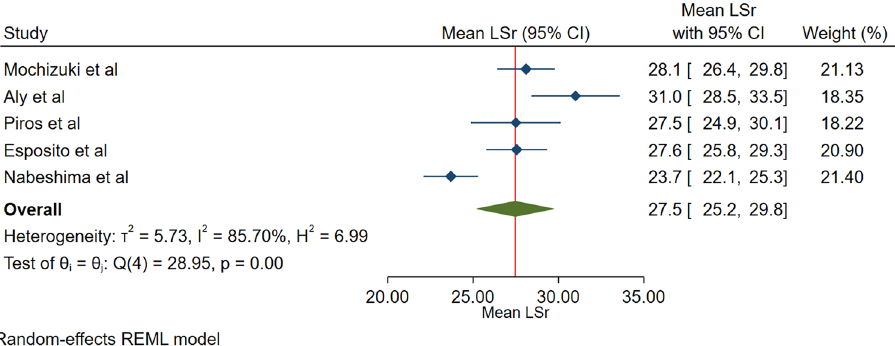
Figure 2. The image depicts the normal range of the longitudinal 3D speckle-tracking echocardiography- derived left atrial strain during the reservoir phase.